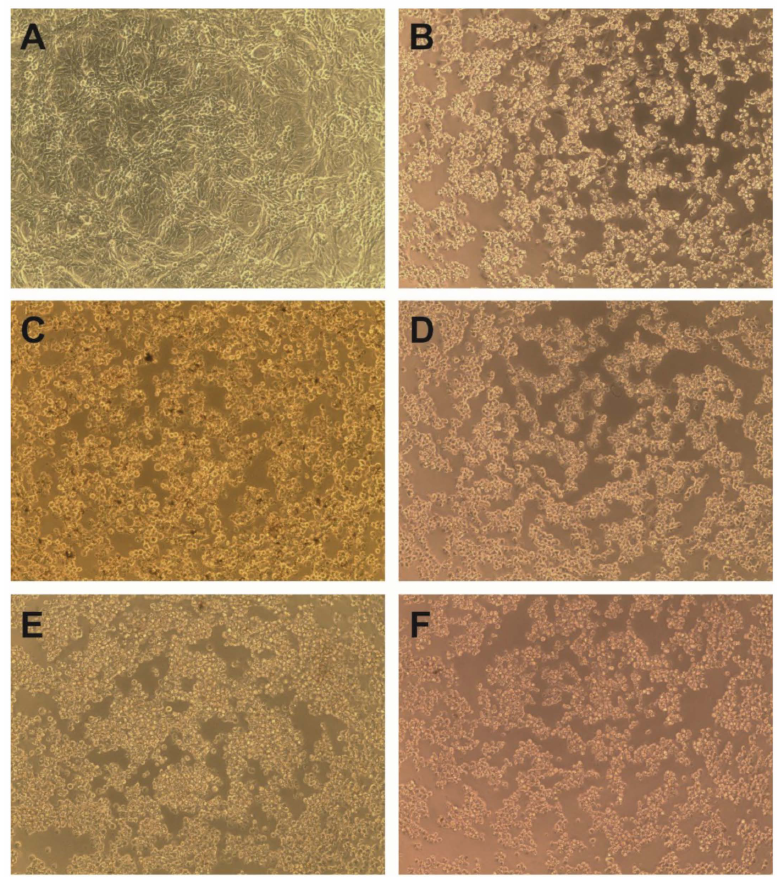
Figure 4. Influence of S. campanulata on the CVB3-induced cytopathic effect (magnification × 100). ( A )—VERO cell control; ( B )—CVB3 induced cytopathic effect (CPE) in infected VERO cells; CVB3 infected VERO cells treated with ScLM 500 µ g/mL ( C ), ScLI 125 µ g/mL ( D ), ScSbM 500 µ g/mL ( E ) or ScSbI 125 µ g/mL ( F